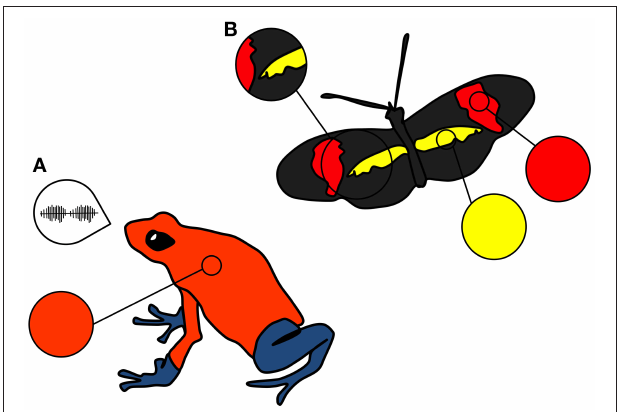
FIGURE 2 | Illustration of the difference between (A) multimodal and (B) multicomponent signals. (A) The strawberry poison frog, Oophaga pumilio, has both visual (color) and acoustic (call) signals. While both are involved in sexual selection (Maan and Cummings, 2012; Dreher and Pröhl, 2014), these stimulate different sensory (visual and auditory) channels or modes in the receiver. (B) The butterfly Heliconius erato has both color and pattern components to its visual signal (Finkbeiner et al., 2014). These may (or may not) encode different information, but stimulate the same sensory channel or mode (vision) in the receiver. Note that we are here focusing only on the visual signal of this butterfly for the purpose of illustrating multicomponency. H. erato is also chemically defended and the combination of its secondary defences and its visual signal make up their multimodal aposematic